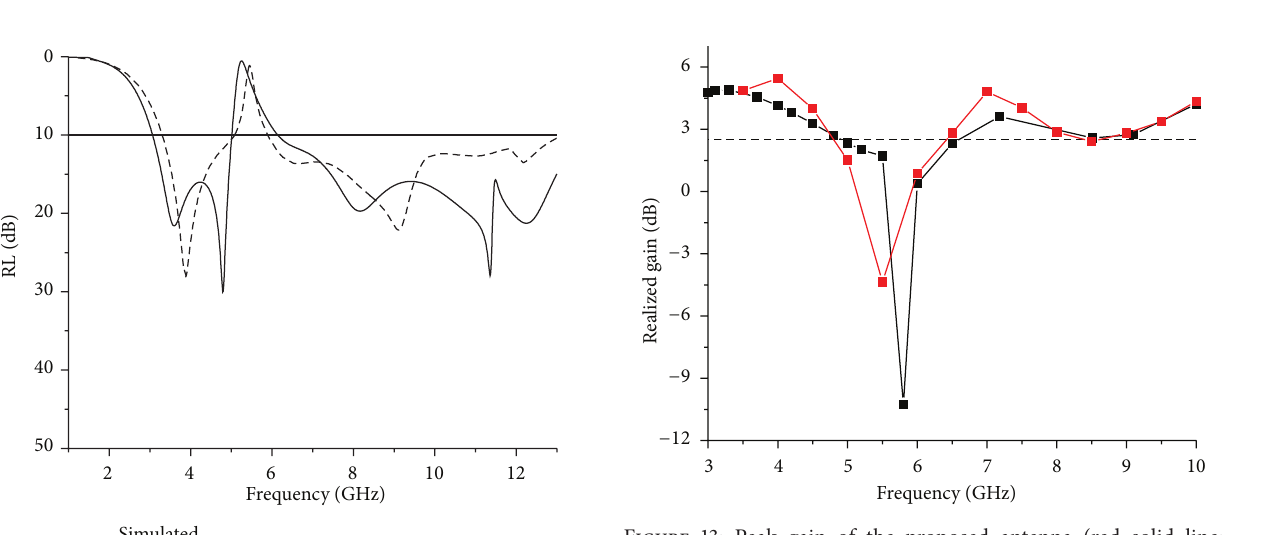
Figure 13: Peak gain of the proposed antenna (red solid line: measured gain and black solid line: simulated